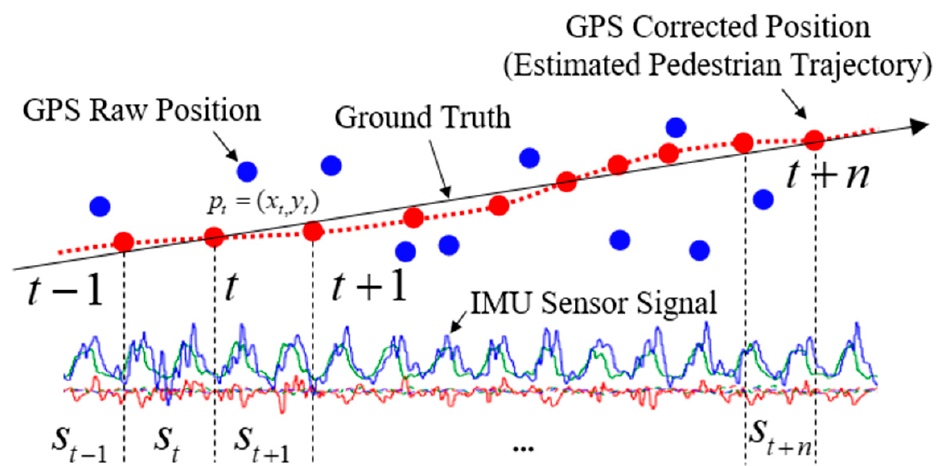
Figure 2. The proposed dataset collection scheme for pedestrian walking patterns in real-time, automatically. The blue dots are the raw GPS positions and the red dots are the corrected GPS positions with a Kalman filter. The moving speed is obtained by the displacement of the current position at t and previous position at t − 1, and it is assigned to a segmented IMU signal every 1 s (i.e., the GPS data update rate is 1 Hz) corresponding to the label directly.